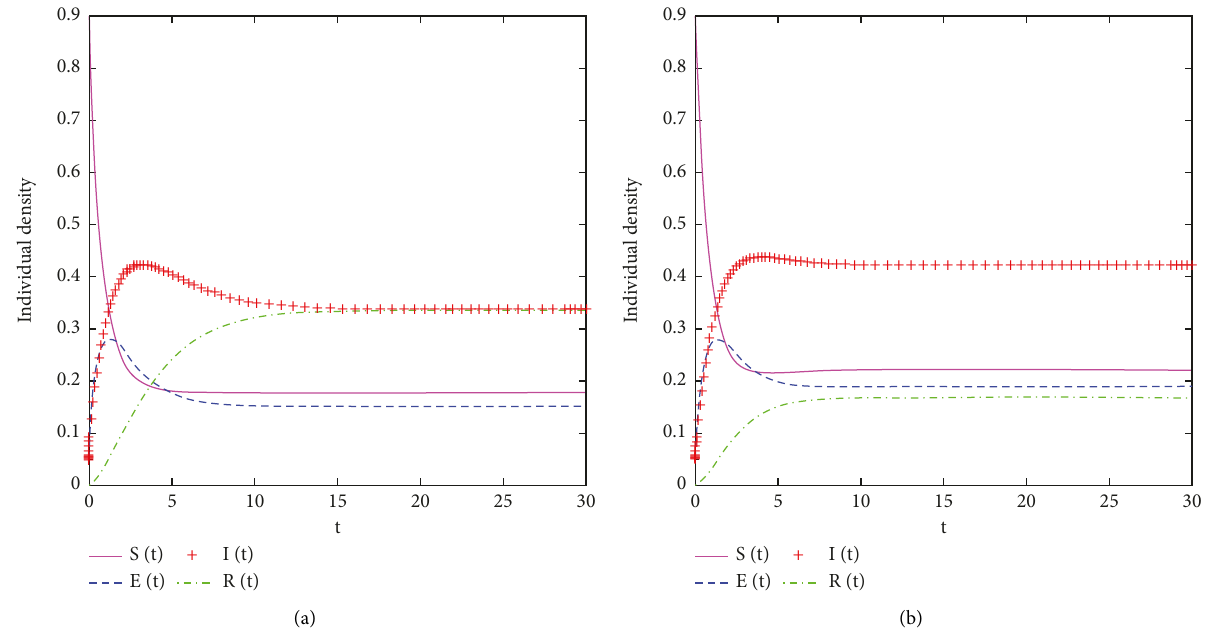
Figure 8: Simulation results of recovered enterprise removal rate on credit risk contagion. (a) c � 0.2. (b) c �